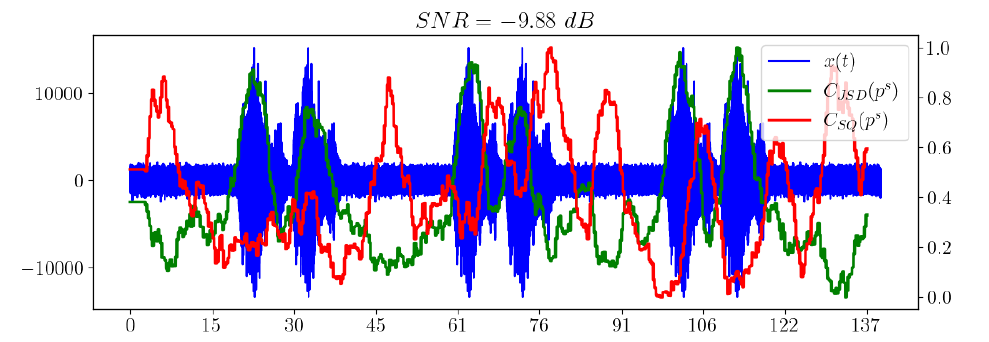
Figure 11. Statistical complexities C SQ and C JSD for pink noise model.